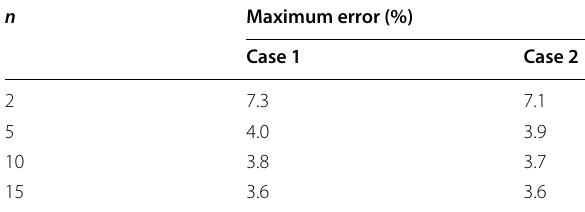
Table 4 Maximum errors between the inferred